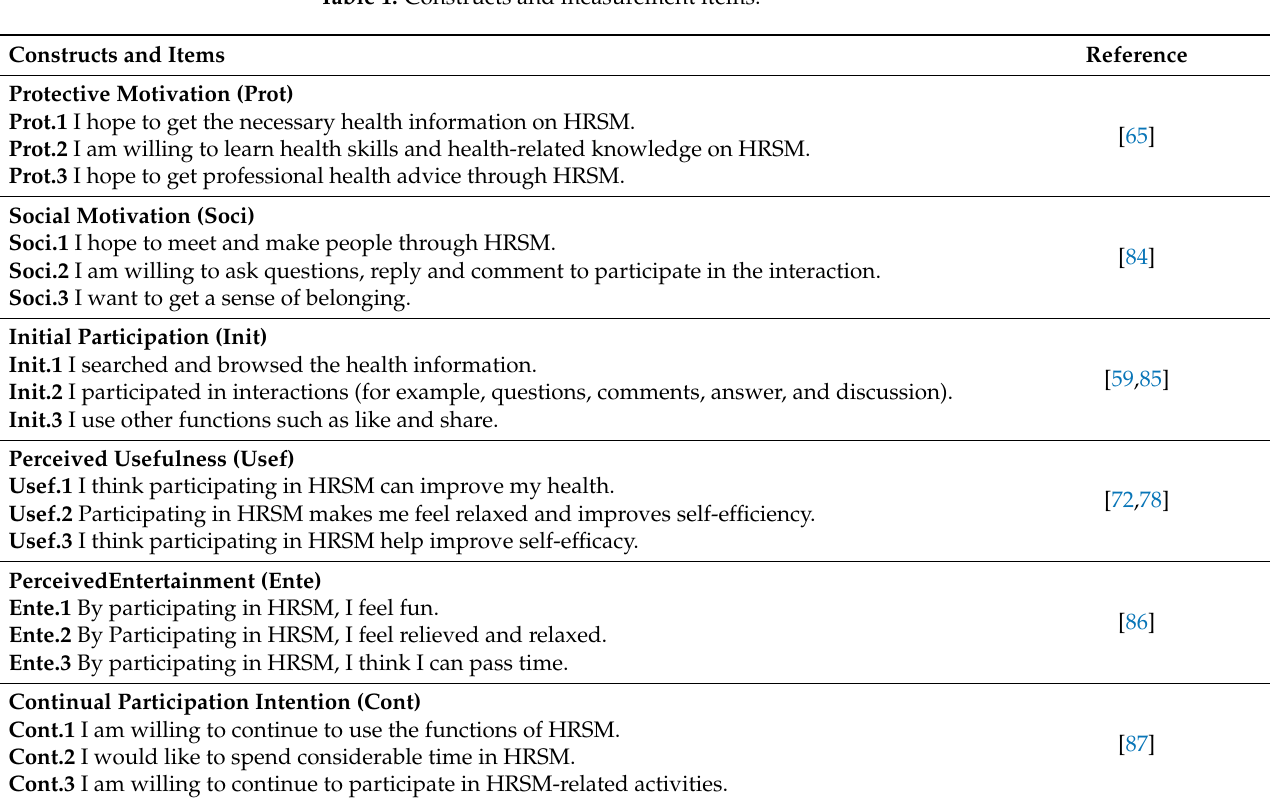
Table 1. Constructs and measurement items.